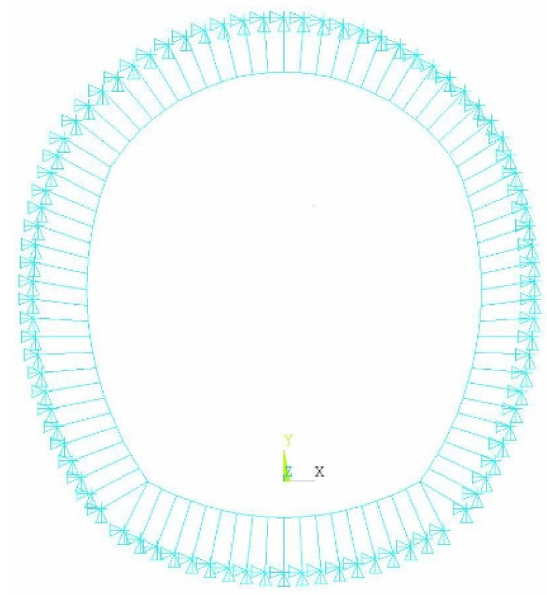
Figure 17. Schematic diagram of the geometric